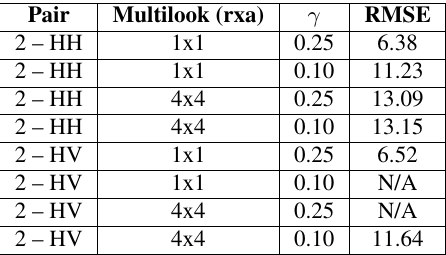
Table 4. RMSE obtained after running the orbital correction with different combinatios of Multilook and γ thresholds. In case of N/A , this means the correction could not be achieved (similar to